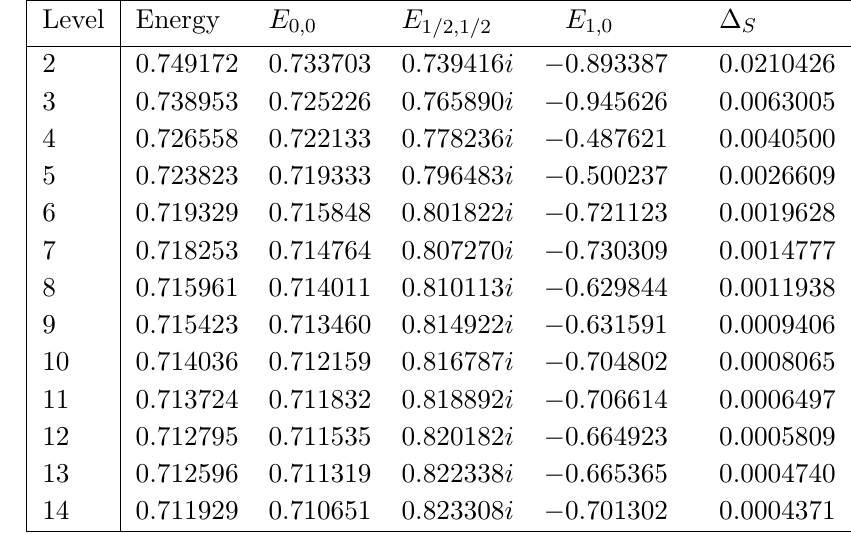
in the k = 2 model 2